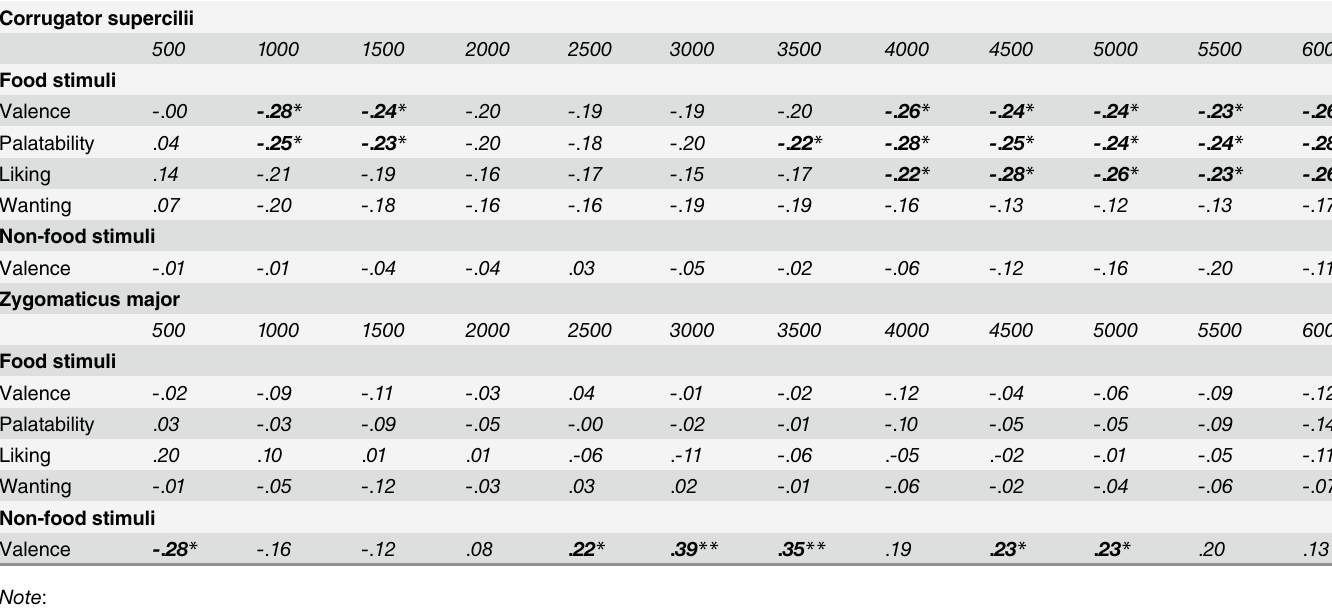
= .250- .820. For the BED- sample there were no significant correlations found. In the NWC